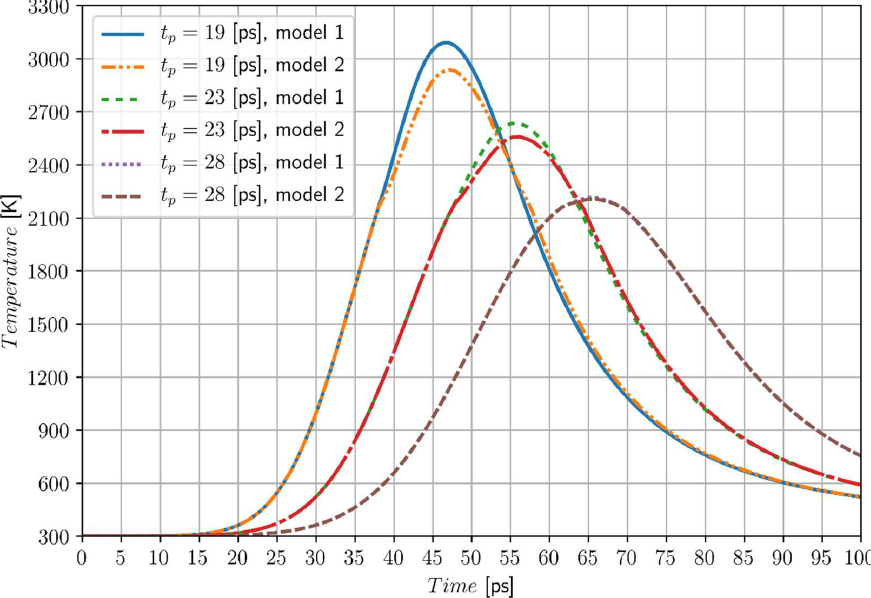
Figure 5. Temperature history at the point P 1 (0, 0), model 1—artificial mushy zone (∆ T =3 K), model 2—melting at the constant temperature, chromium, I 0 = 2.6 × 10 4 J/m 2.